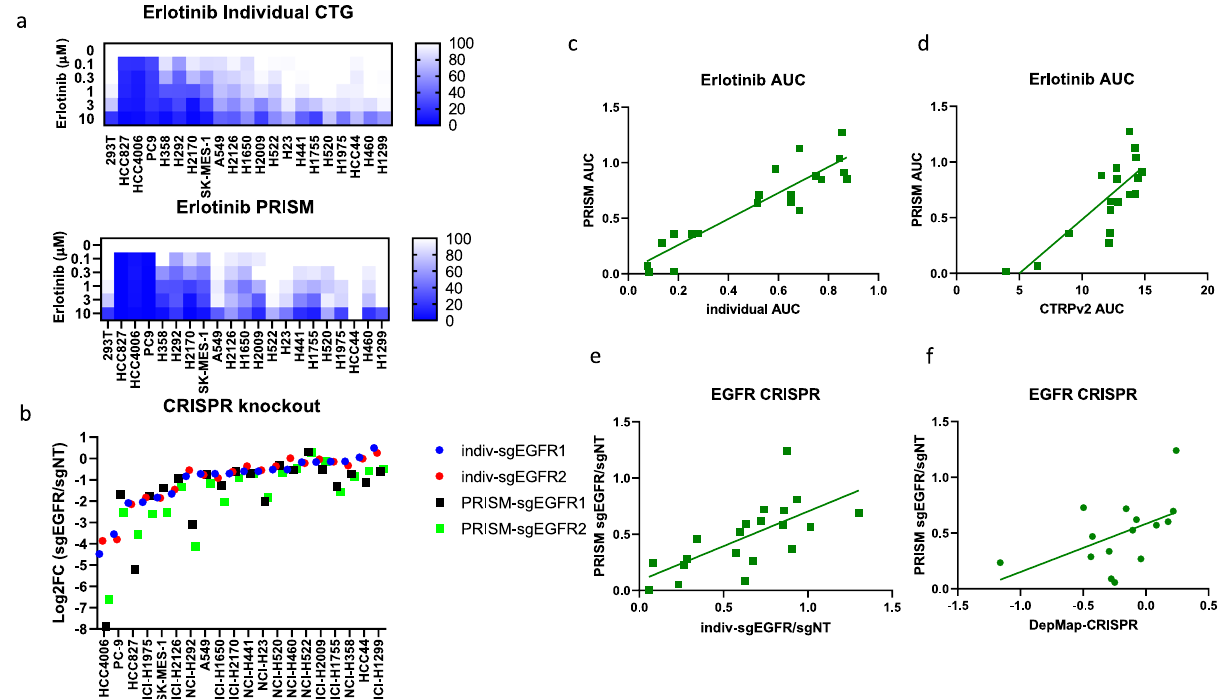
Fig. 2 EGFR-dependency evaluation in a focused PRISM analysis of 20 NSCLC lines. a Heatmap showed the response of 20 NSCLC lines to 5-day Erlotinib treatment (0, 0.1, 0.3, 1, 3, 10 µ M) in individual CellTiter-Glo assay (top) or PRISM assay (bottom). b EGFR gene dependency of 20 NSCLC lines was evaluated by CRISPR competition assay (7 day, solid circles) and PRISM assay (5 day, solid squares). EGFR gene was knocked out by two single guide RNAs (sgEGFR1 and sgEGFR2), respectively. c Correlation analysis of Erlotinib AUC in individual CTG assay vs PRISM assay (20 cell lines, r = 0.9097). d Correlation analysis of Erlotinib AUC in PRISM assay vs AUC reported by Cancer Therapeutics Response Portal (CTRPv2, 18 cell lines, r = 0.7969). e Correlation analysis of EGFR CRISPR competition assay vs PRISM assay (plotted with average of two sgRNAs, 20 cell lines, r = 0.6844). f Correlation analysis of EGFR CRISPR PRISM assay vs DepMap gene effect score (CERES, 15 cell lines, r =